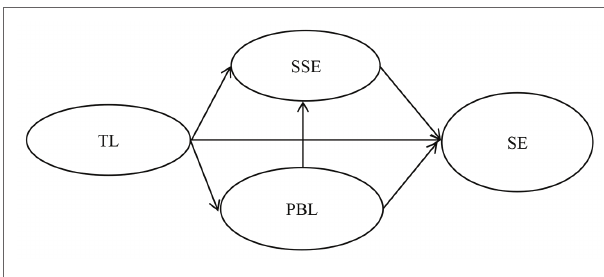
FIGURE 1 | Research